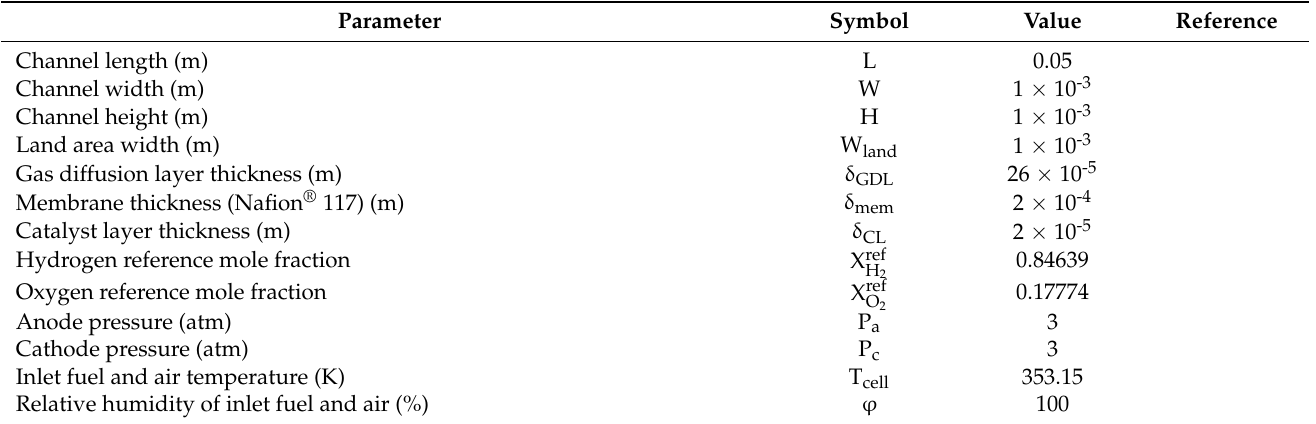
Figure 1. Flow diagram of the solution’s algorithm. Table 1. Geometrical, operational, electrode, and membrane parameters.